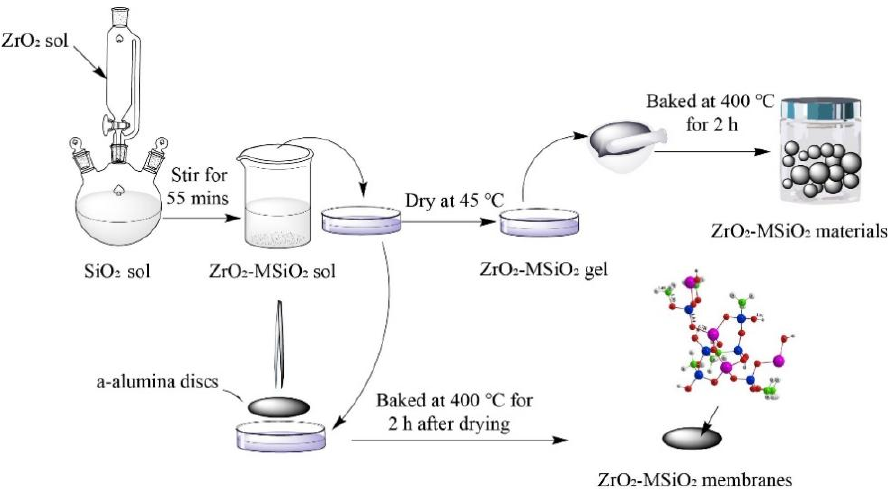
Figure 1. Schematic diagram of the preparation of ZrO 2 -MSiO 2